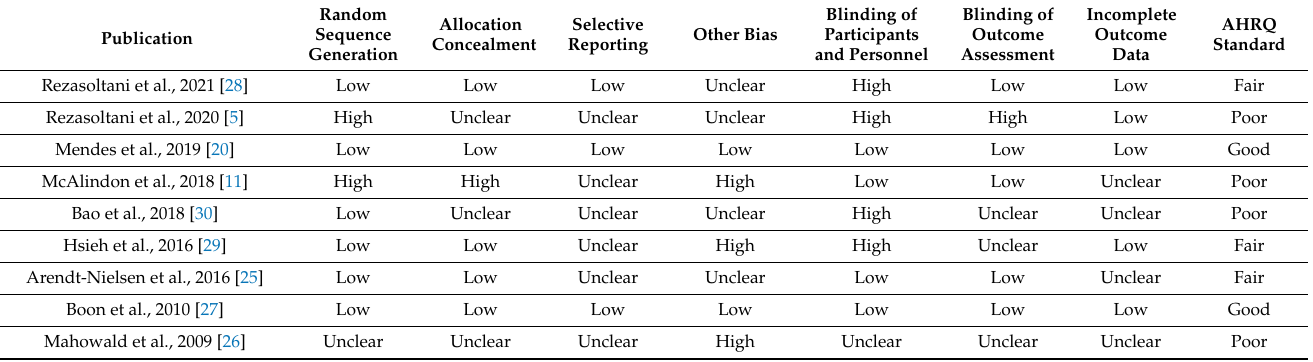
Table 2. Quality Assessment of the Included Studies by using the Cochrane Risk of Bias tool for Randomized Controlled Trials and the AHRQ (Agency for Healthcare Research and Quality)